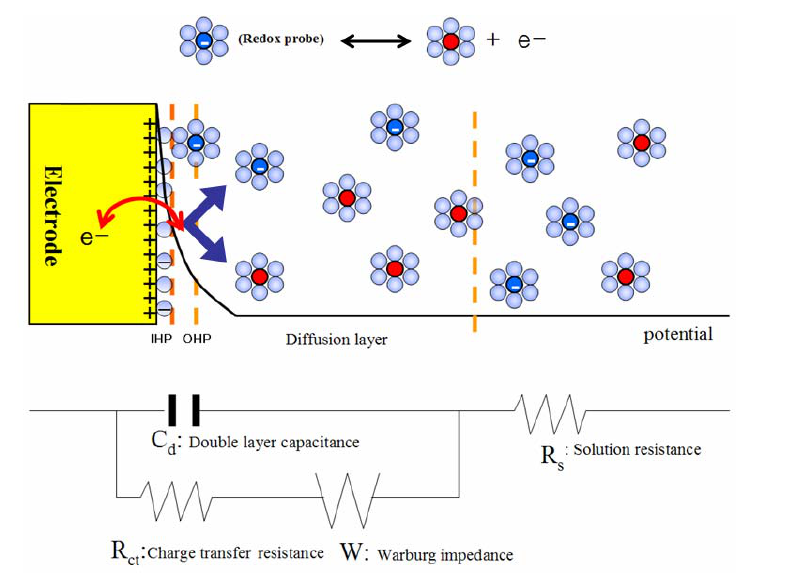
Figure 1. Schematic diagram for an electrode/electrolyte interface in a faradaic sensor and its exemplary model circuit